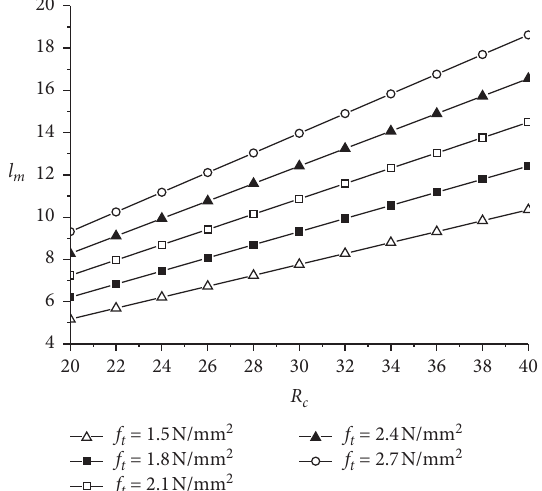
Figure 10: The relationship between R